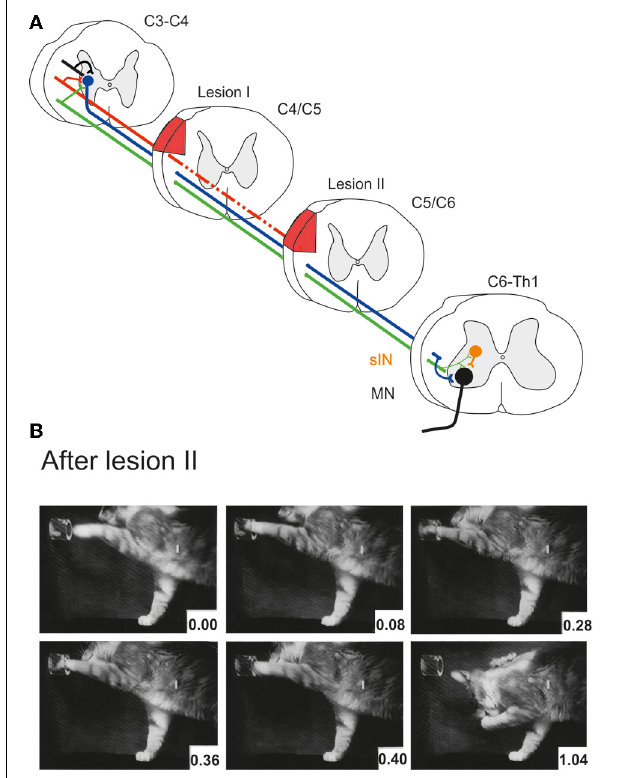
FIGURE 3 | (A) Serial lesions of the rubro- and corticospinal tracts in the DLF in two time-separated sessions. Lesion I (complete CST, partial RuST) was made in C4/C5. Lesion II (complete CST and RuST) was made in C5/C6 1 month after lesion I. (B) Successful digit grasping in the first experiment (6 days postoperatively) after lesion II. (B) Modified from Pettersson (1990).